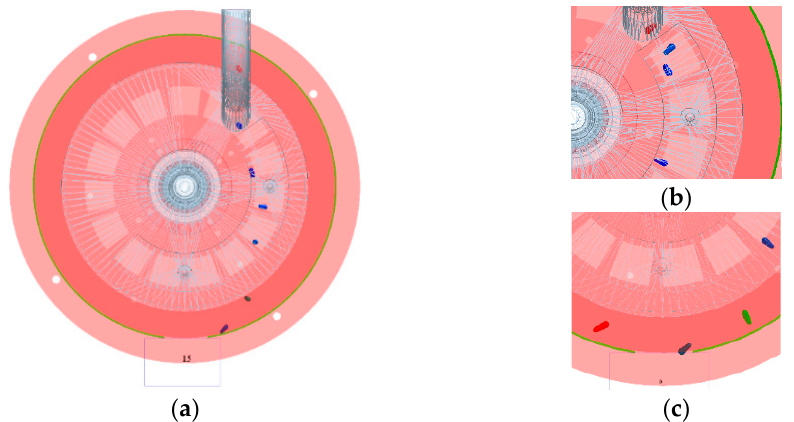
Figure 14. Seed discharge process for hole sowers. ( a ) The phenomenon of single grain precision sowing. ( b ) The phenomenon of resowing. ( c ) The phenomenon of omission of sowing.